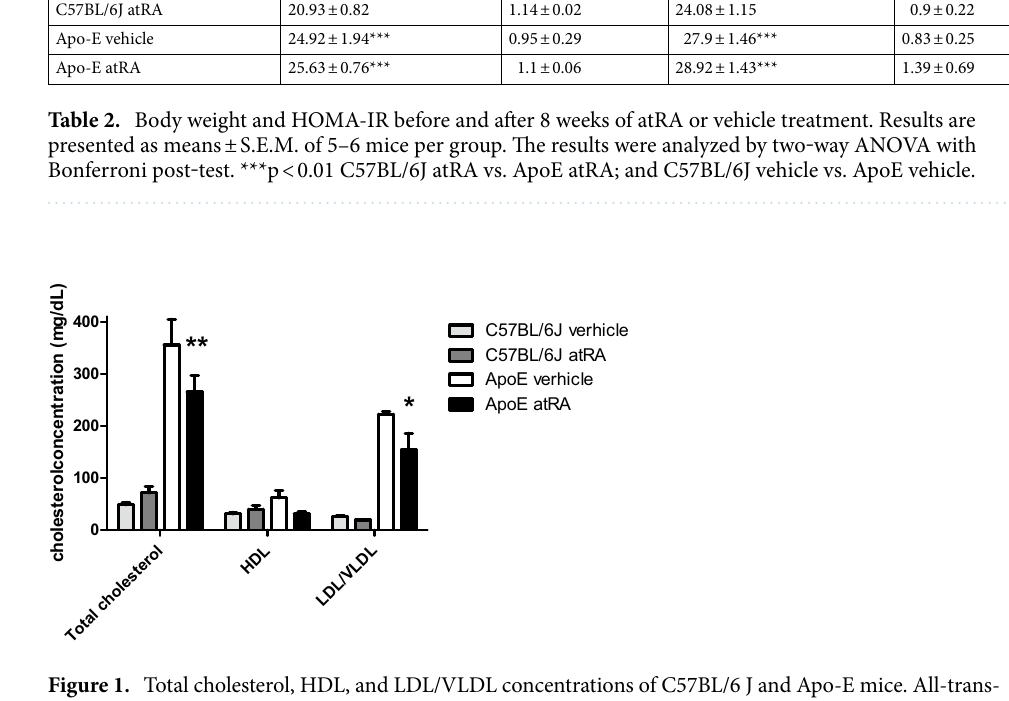
Figure 1. Total cholesterol, HDL, and LDL/VLDL concentrations of C57BL/6 J and Apo-E mice. All-trans- retinoic acid (5 mg/kg/day) or vehicle (corn oil) was administered orally by plastic feeding tubes for 8 weeks. Results are presented as means ± S.E.M. of 5–6 mice per group. The results were analyzed by two ‐ way ANOVA with Bonferroni post ‐ test. *p < 0.01 ApoE atRA vs. ApoE